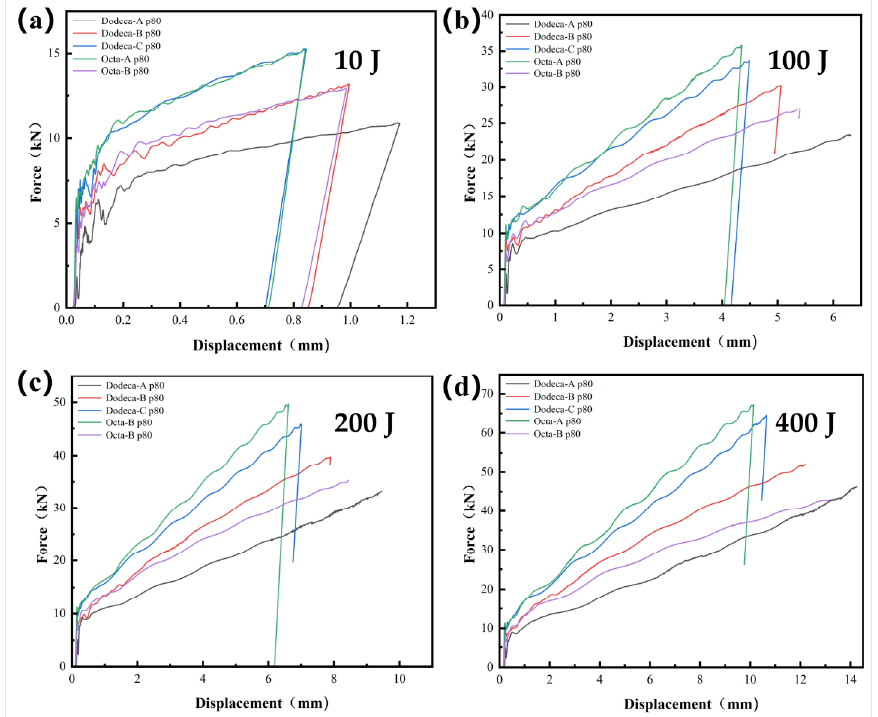
Figure 4. Force-displacement curves of 80%-porosity structures tested at different impact energies: